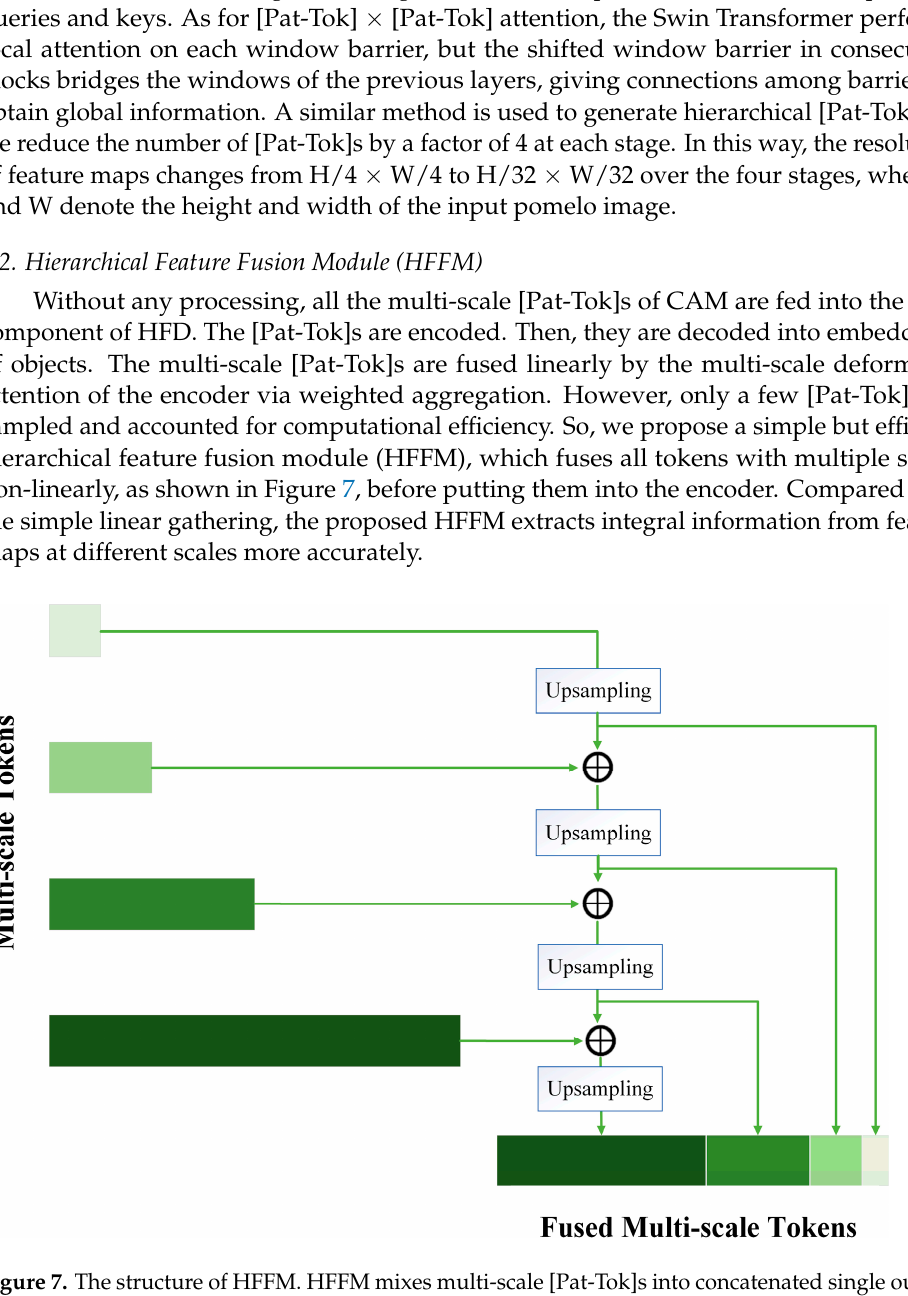
Figure 7. The structure of HFFM. HFFM mixes multi-scale [Pat-Tok]s into concatenated single output. feature maps at different scales with the same size (256) of channel dimension. They are feature maps for hierarchical feature fusion. The feature map in lower resolution is resized by the upsampling operator. Then, HFFM fuses the low-resolution feature map with the high-resolution one by bilinear interpolation. Hence, HFD can obtain fused multi-scale features, flattened with the spatial dimension, and chained for all scales as input to the encoder in the neck component of